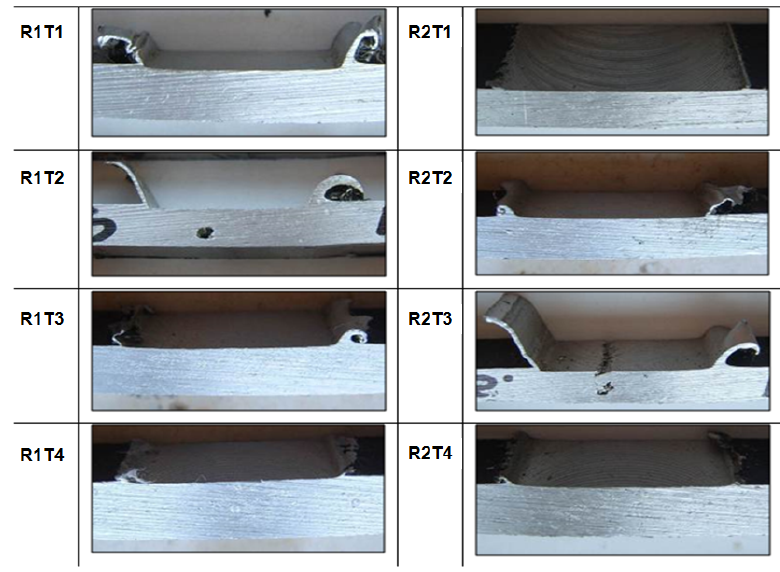
Figure 7. Visual examination of the section of joints.